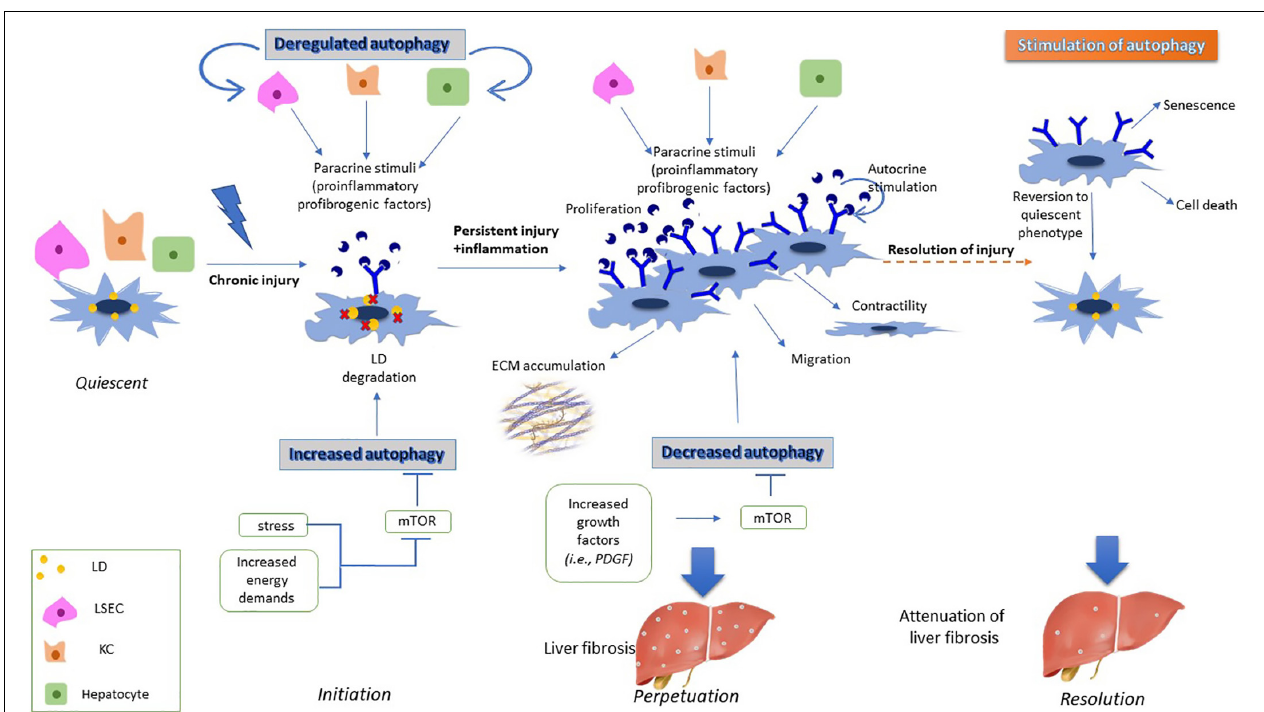
FIGURE 1 | Effects of autophagy on HSC activation. During initiation phase, dysregulation of autophagy in injured liver cells such as LSECS, KCs and hepatocytes result in secretion of proinflammatory and profibrogenic signals. These signals are incorporated by HSCs, thus inducing expression of various membrane receptors, and becoming more responsive to external signals. Moreover, increased energy demands of HSCs during their transformation to myofibroblast cells results in degradation of their lipid droplets through lipophagy. During perpetuation phase, increased expression of growth factors in aHSCs leads to downregulation of autophagy, with aHSCs having acquired fibrogenic properties such as proliferation, contractility and secretion of ECM components, thus leading to liver fibrosis. However, induced autophagy during the perpetuation phase leads to either senescence, cell death or reversion of aHSCs to their quiescent phenotype resulting in attenuation of the fibrotic